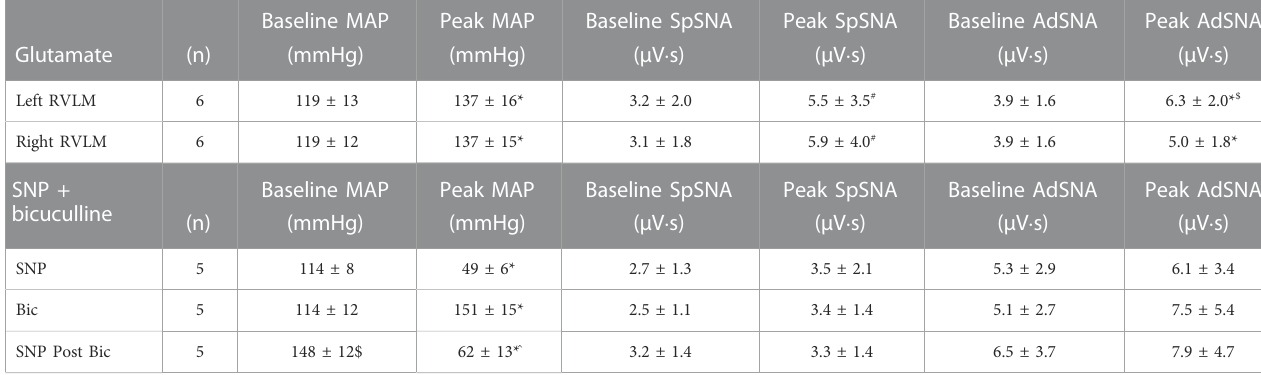
TABLE 1 Absolute values before and after microinjections of glutamate in the left or right RVLM, or after intravenous injections of sodium nitroprusside before and after bilateral microinjections of bicuculline into the RVLM. Baseline MAP Peak MAP Baseline SpSNA Peak SpSNA Baseline AdSNA Peak